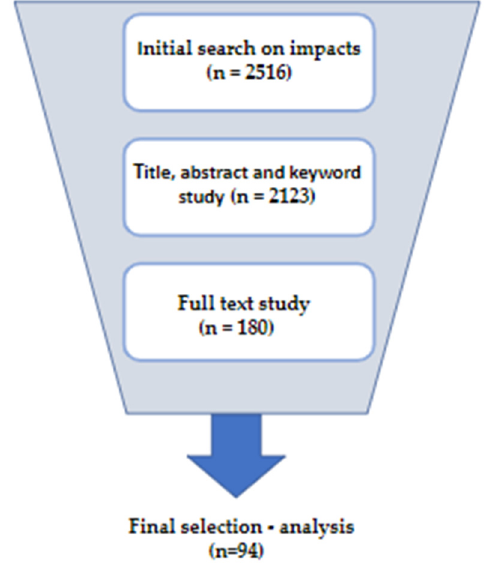
Figure 2. Selection of studies.